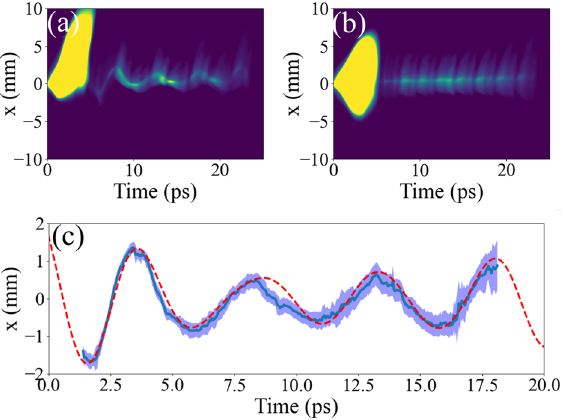
Figure 6. Time-resolved transverse wakefield measurement. ( a , b ) Beam’s x–t distribution with and without the corrugated structure, respectively. ( c ) The comparison of the measured transverse wakefield (blue-solid) and the simulated wakefield (red-dash). The blue shade corresponds to ± 1 σ statistical